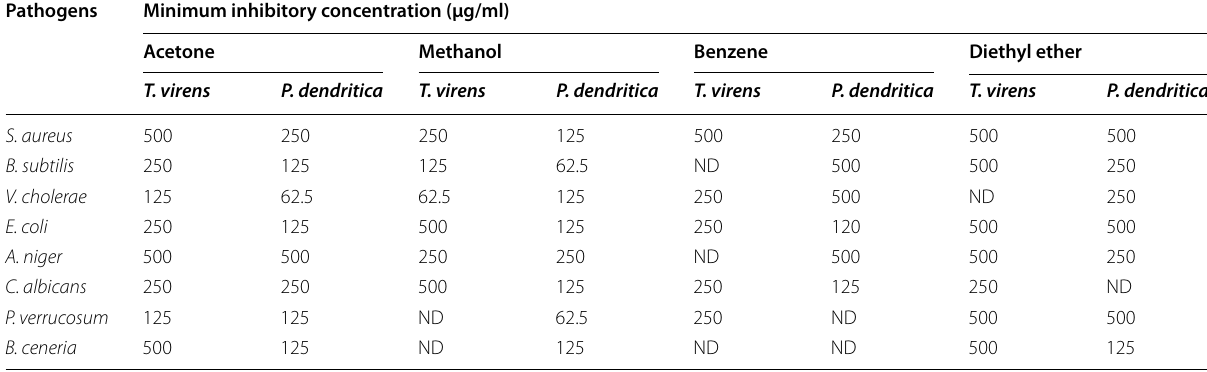
Table 7 Antimicrobial activity (MIC) against pathogenic microbes across different solvent extraction Pathogens